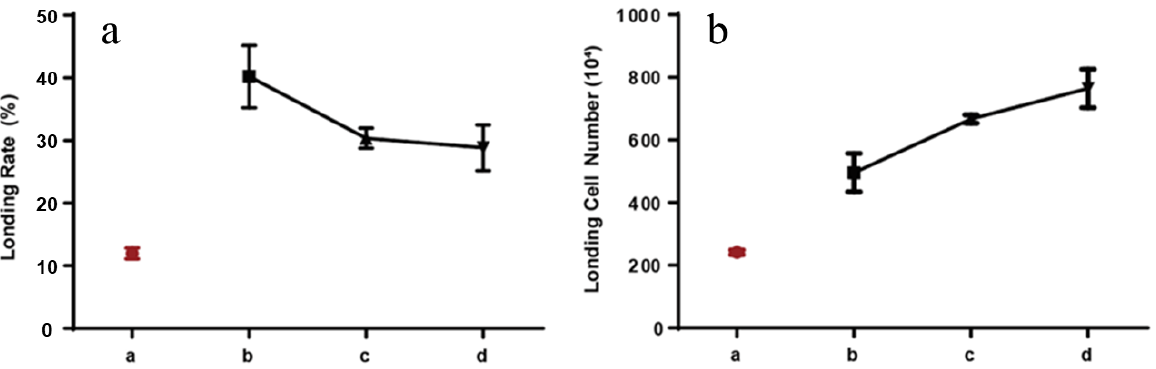
Figure 2. Loading rate ( a ) and loading number ( b ) of HSF and RAW246.7 cells in a microsphere: ( a ) red point was a HSF loading rate, and black points were the loading rate of RAW246.7 cells (density of 0.50 × 10 7 /mL—point b in figure ( a ); density of 1.0 × 10 7 /mL—point c in figure ( a ); density of 1.50 × 10 7 /mL—point c in figure ( a ); ( b ) red point was HSF loading number, and black points were the loading number of RAW246.7 cells (density of 0.50 × 10 7 /mL—point b in figure ( a) ; density of 1.0 × 10 7 /mL—point c in figure ( a) ; density of 1.50 × 10 7 /mL—point c in figure ( a ).